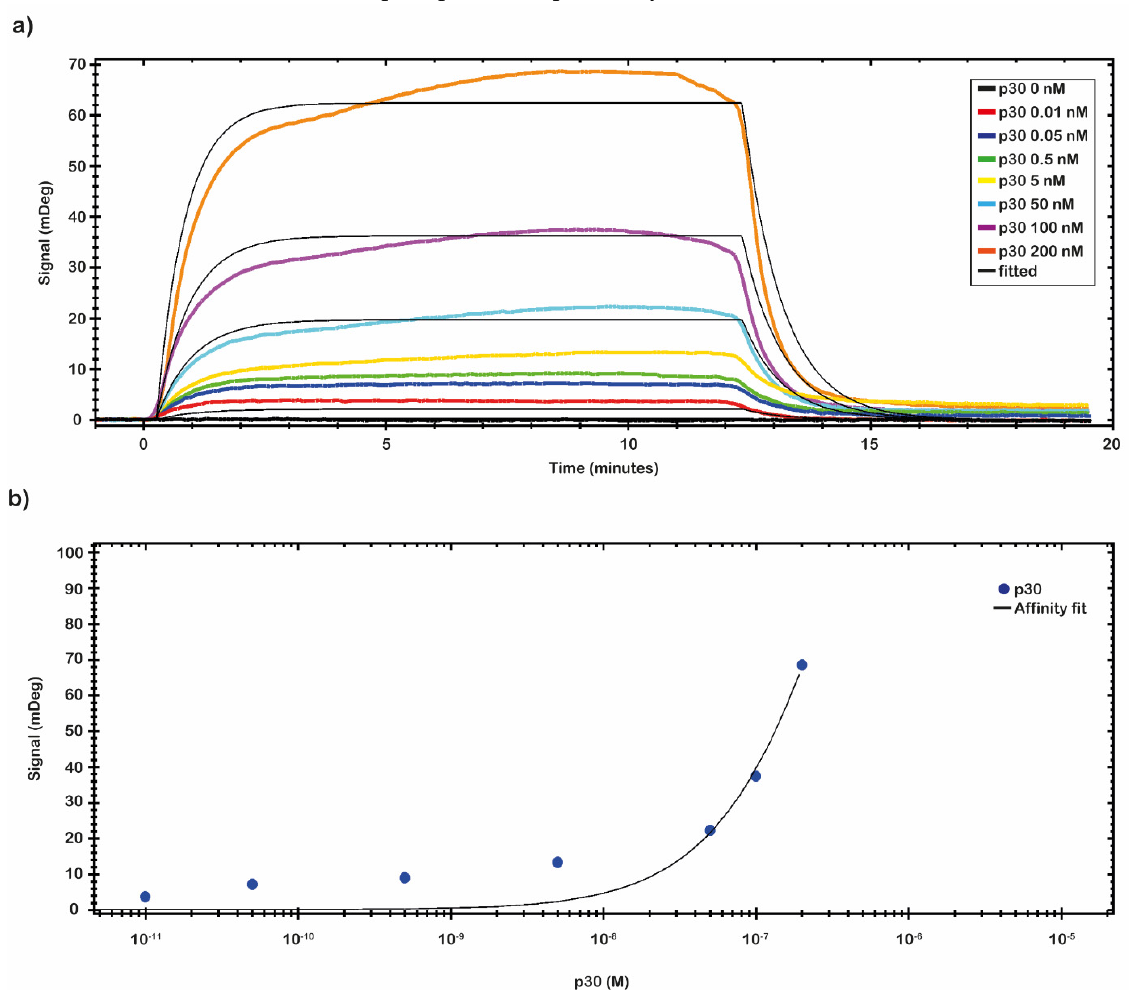
Figure 4. SPR assay setting up, kinetics and affinity analysis. ( a ) A complete kinetic analysis was performed with the recombinant antigen p30 in a nanomolar range (from 0.01 to 200 nM). Sensorgrams shows the binding of recombinant p30 pRec protein to anti-ASFV covalently immobilized on the sensor chip surface. All measurements were performed in 10 mM NaP pH 7.4 buffer at room temperature. ( b ) An affinity plot was obtained from the same set of collected data. The blue dots represent the values of the p30 pREC titration experiment performed by the SPR-based sensing system. mDeg values are plotted versus pRec concentration; the black curve shows a result of a non-linear fitting operation. The obtained K D , LOD, and Bmax values, calculated by TraceDrawer™ data analysis software, were respectively 5.04 × 10 − 7 ± (8.24 × 10 − 11 ) M, 0.01 nM, and 239 ± (0.03) mDeg. Table 2. Kinetic analysis results of the complex anti-ASFV-p30.